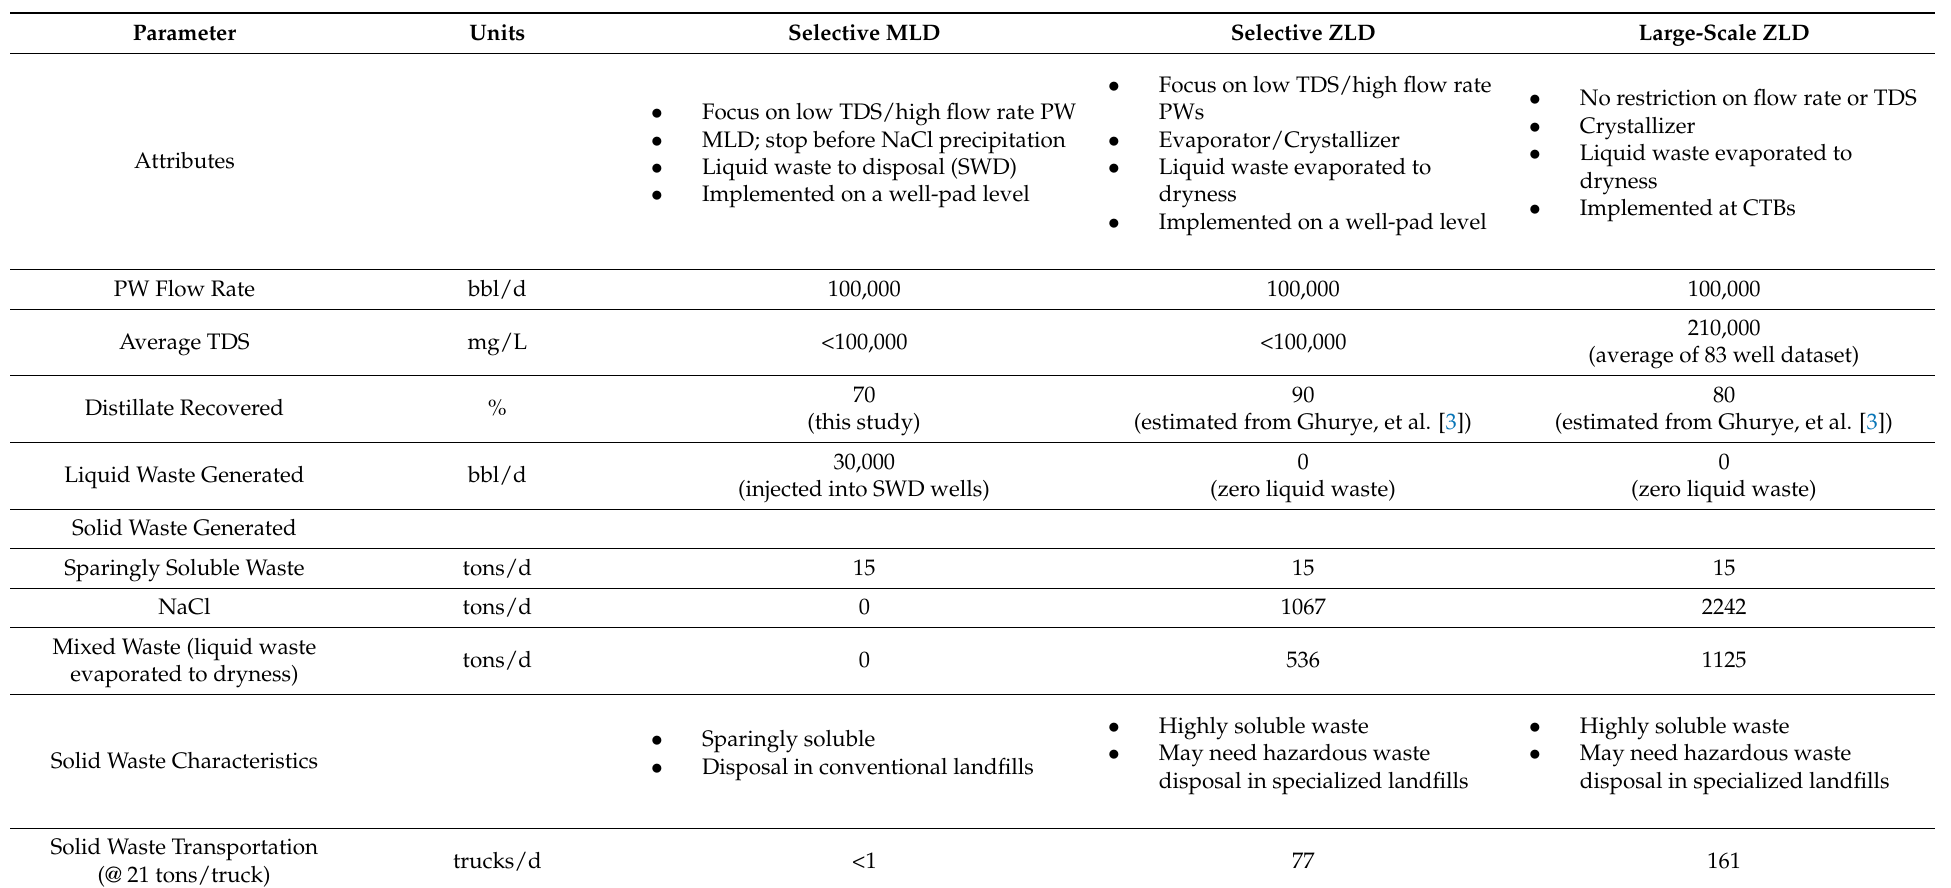
Table 3. Comparison of Selective MLD and Selective and Large-Scale ZLD approaches for PW